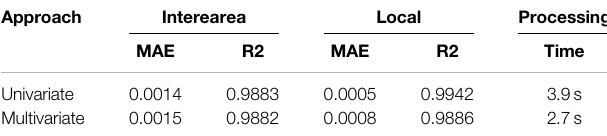
TABLE 1 | Performance of RF on test set.